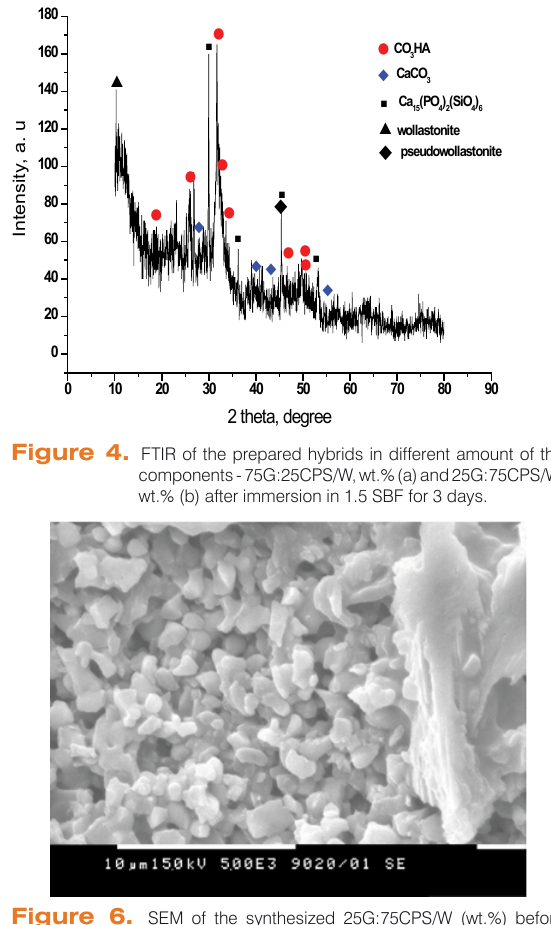
Figure 6. SEM of the synthesized 25G:75CPS/W (wt.%) before immersion in 1.5 SBF.